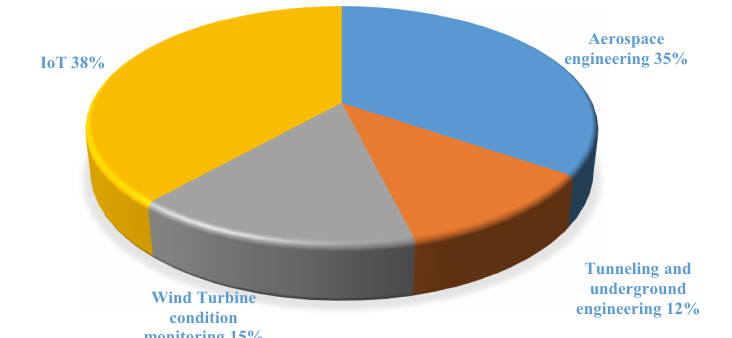
Figure 8. Distribution of papers about DT in various engineering